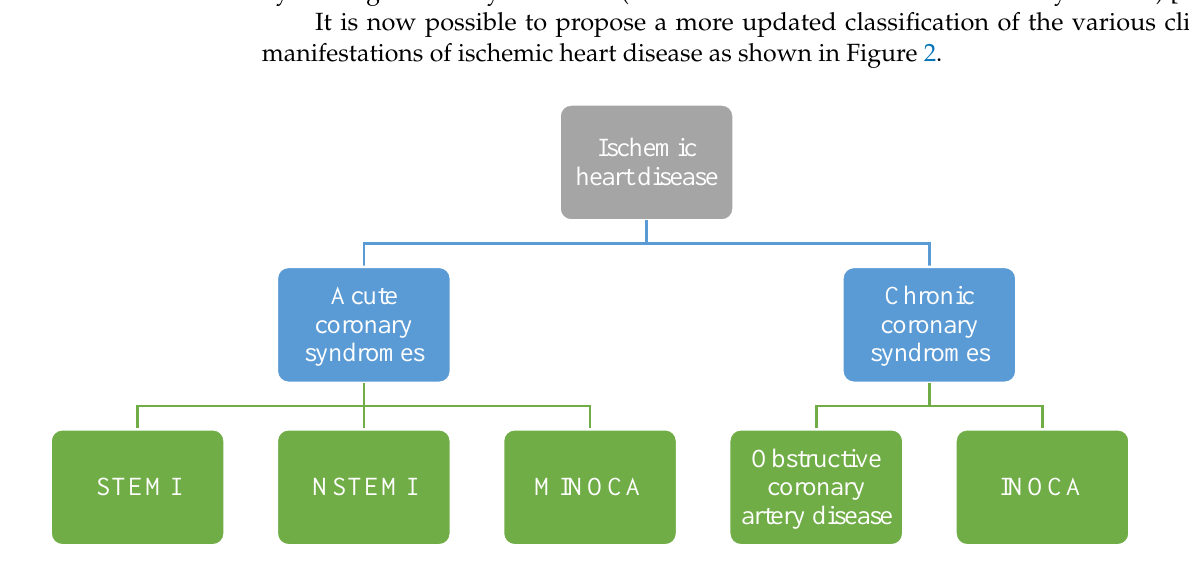
Figure 1. Angina without obstructive disease in the epicardial coronary arteries.